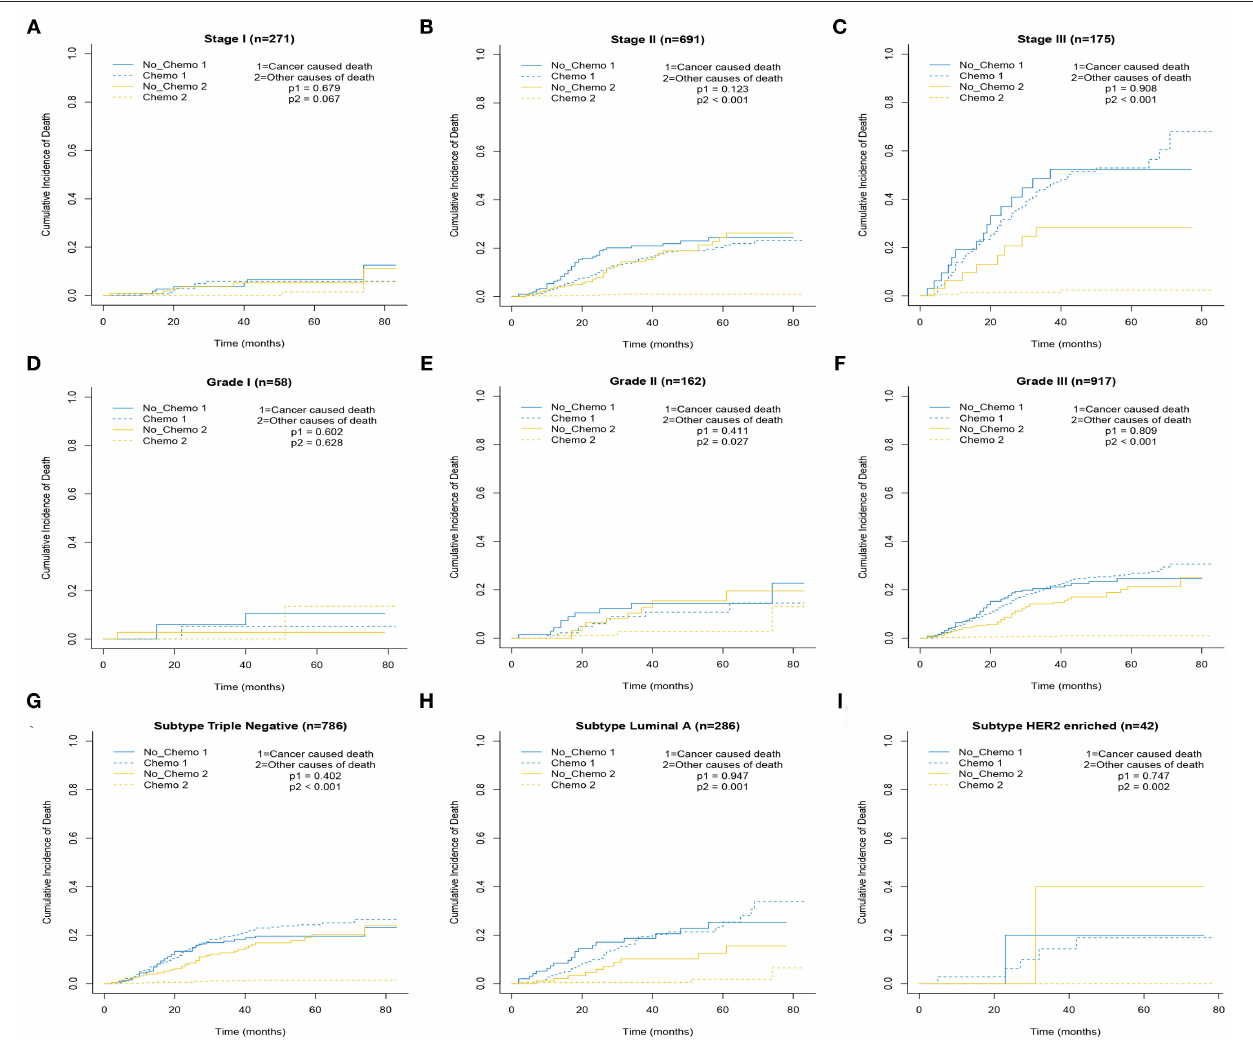
FIGURE 2 | Cumulative incidence plot depicting cancer-caused death and other cause mortality according to stage (A–C) , grade (D–F) , and subtype (G–I) .